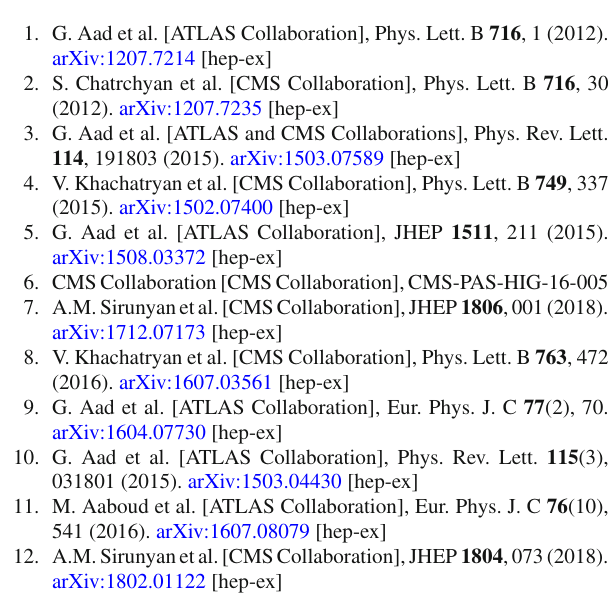
+ p j 2 , being T T